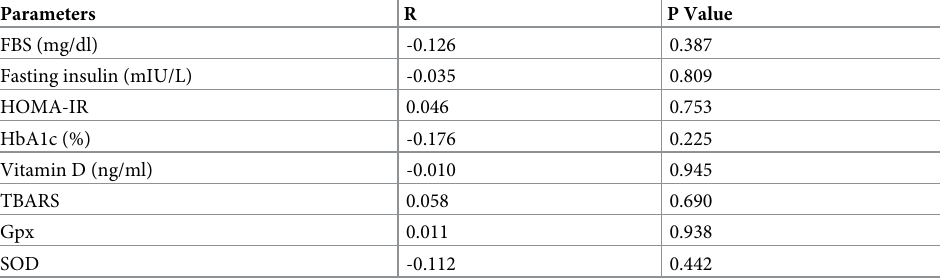
Table 6. Correlation between 3MS score and various biochemical parameters among diabetic subjects with vita- min D insufficiency. Parameters